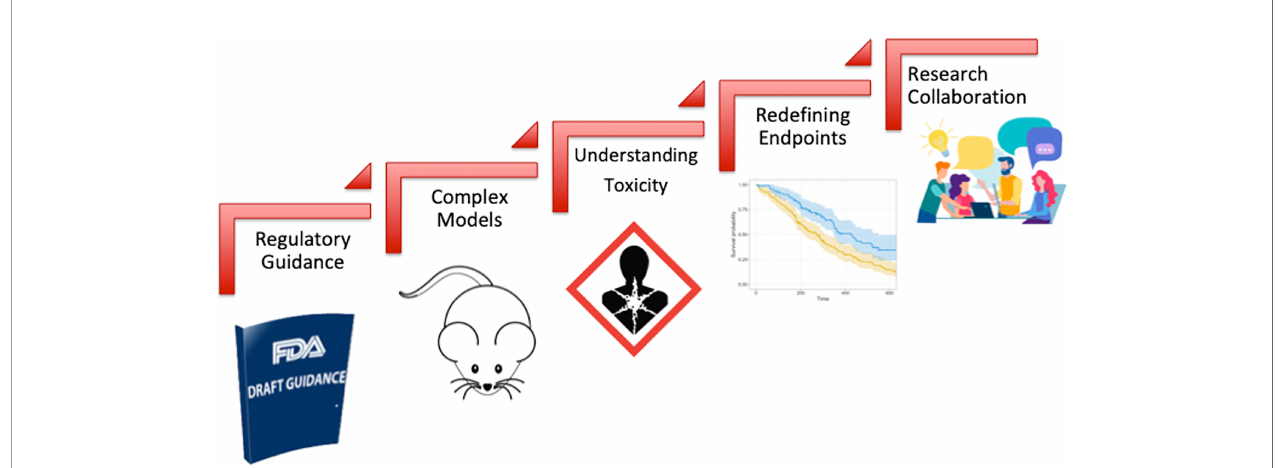
FIGURE 3 | Challenges of clinical development of novel drug-radiotherapy